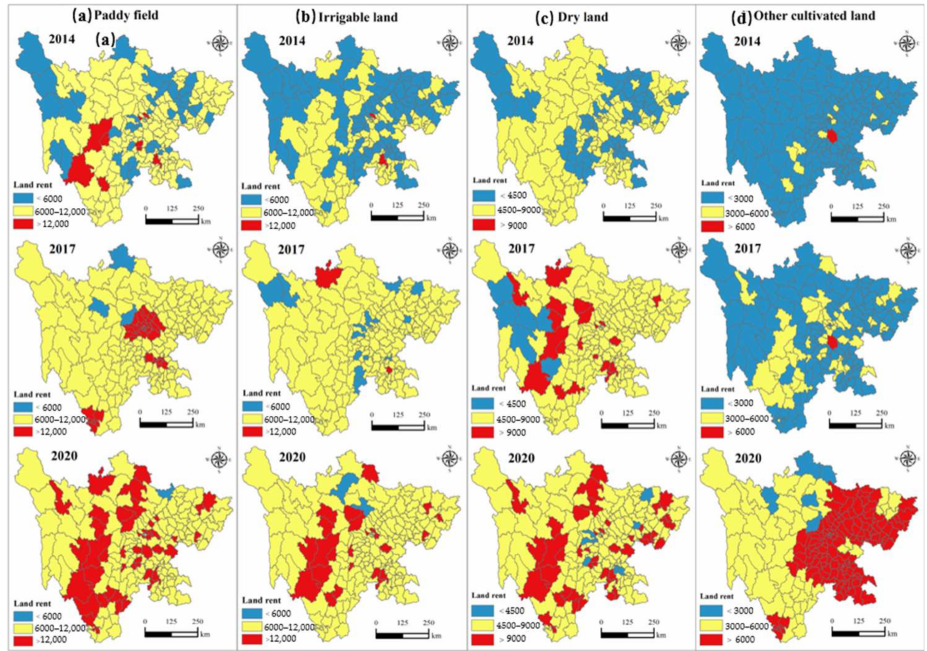
Figure 4. Spatiotemporal variations in farmland rents at district and county